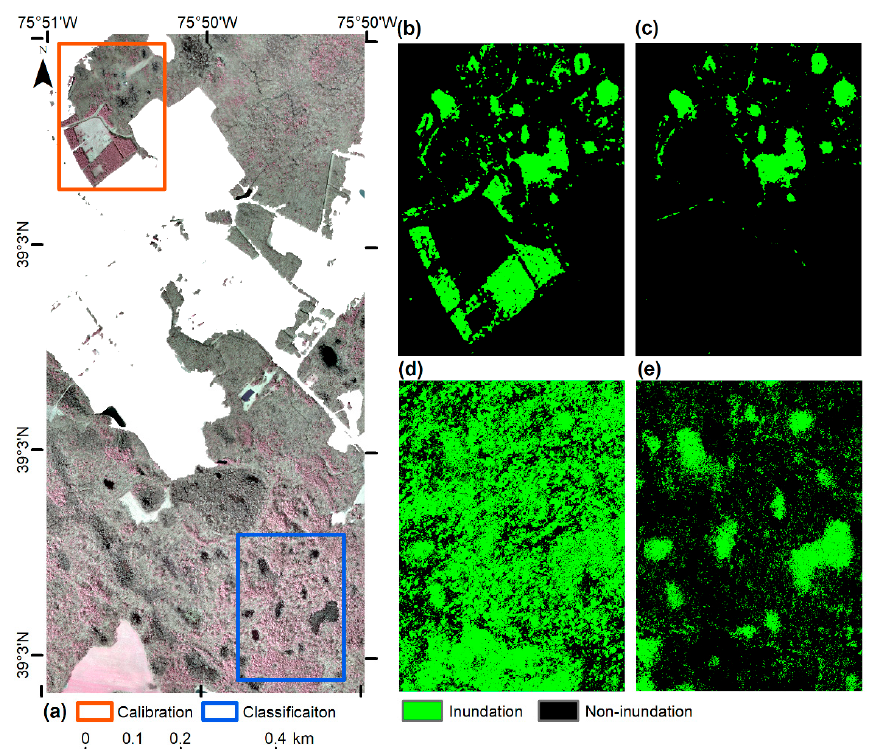
Figure 9. Maximum likelihood classification of forested wetland inundation based on inundation training data derived from the 2007 lidar intensity data and coincident optical imagery. Panel ( a ) is 2007 digital false-color imagery with the red box showing the calibration extent and the blue box showing the classification extent. Panels ( b ) and ( c ) are the inundation training datasets derived from non-normalized and normalized bare earth 2007 lidar intensity data, respectively. Panels ( d ) and ( e ) are the classification results based on trained classifiers using non-normalized and normalized bare earth 2007 lidar intensity data, respectively.